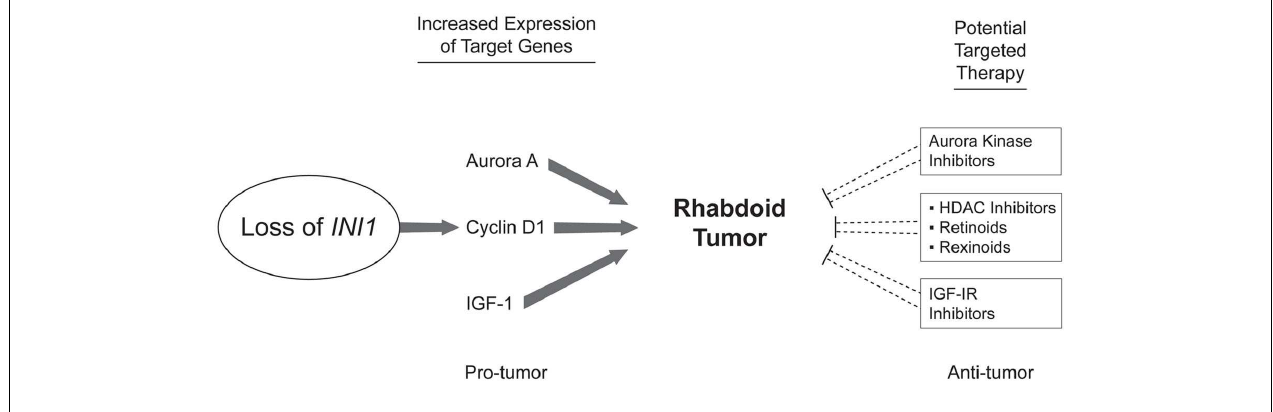
analogs such as retinoids and rexinoids have been shown to inhibit cyclin D1. Aurora A signaling has also been shown to be important in ATRT and multiple inhibitors of Aurora kinase signaling are available. IGF-IR signaling may also play a role in ATRT and inhibitors are available for